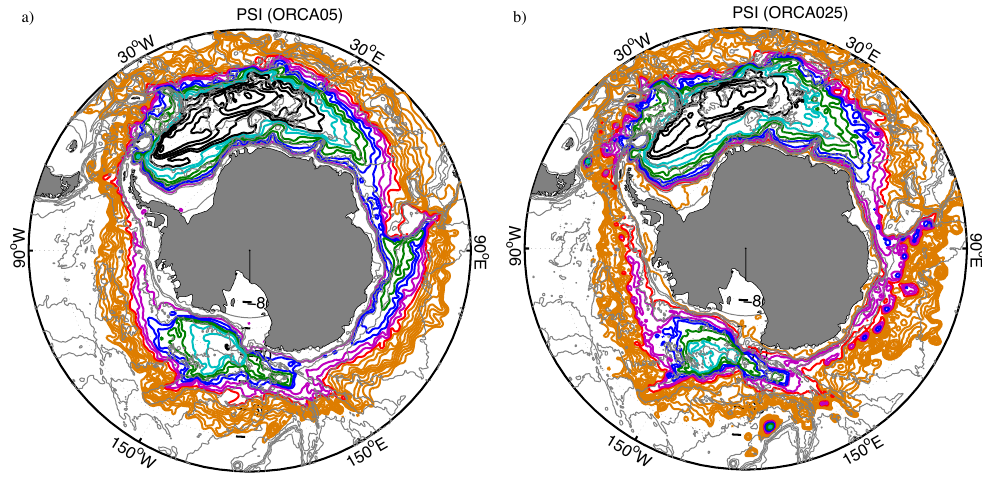
Fig. 6. Annual streamlines in the Southern Ocean for ORCA05 (a) and for ORCA025 (b) . Step between two lines is 5Sv. The ASC is defined here by the southern part of the gyres. Gray lines correspond to bathymetry (plotted each